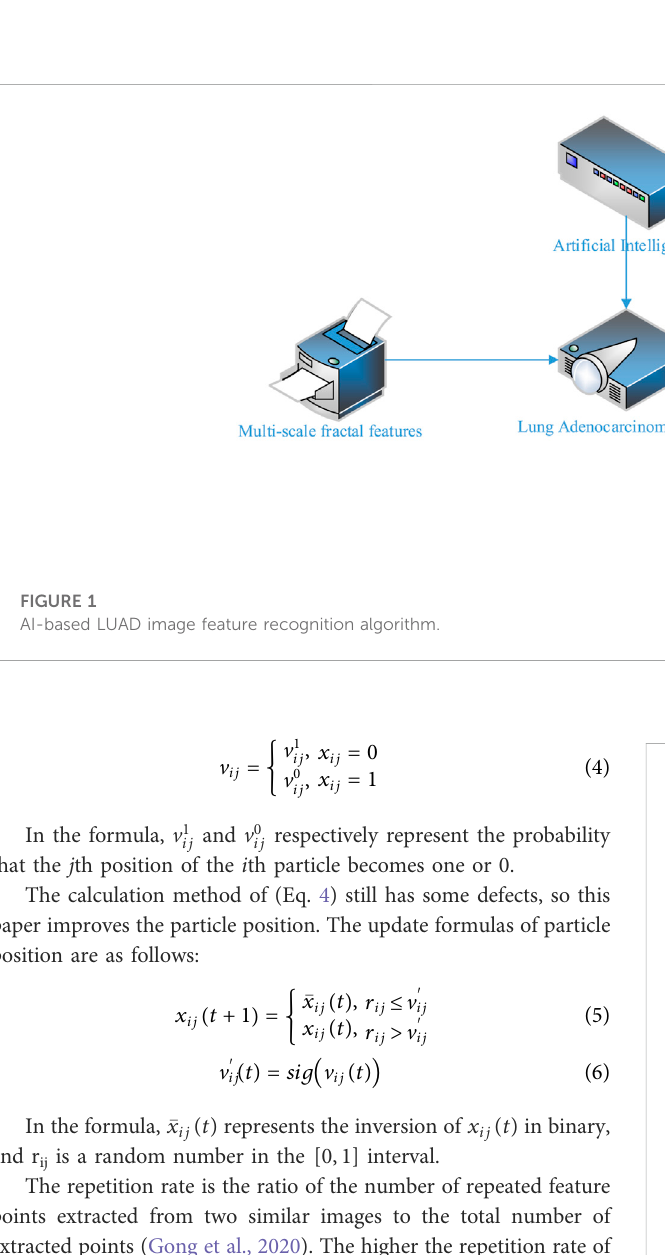
FIGURE 2 Advantages of smart